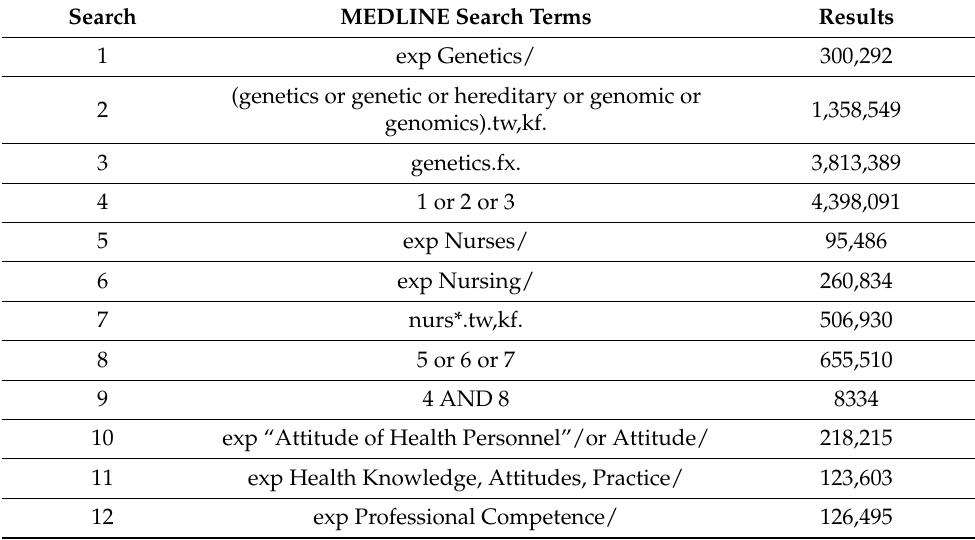
Table 3. MEDLINE draft search strings, 1 June